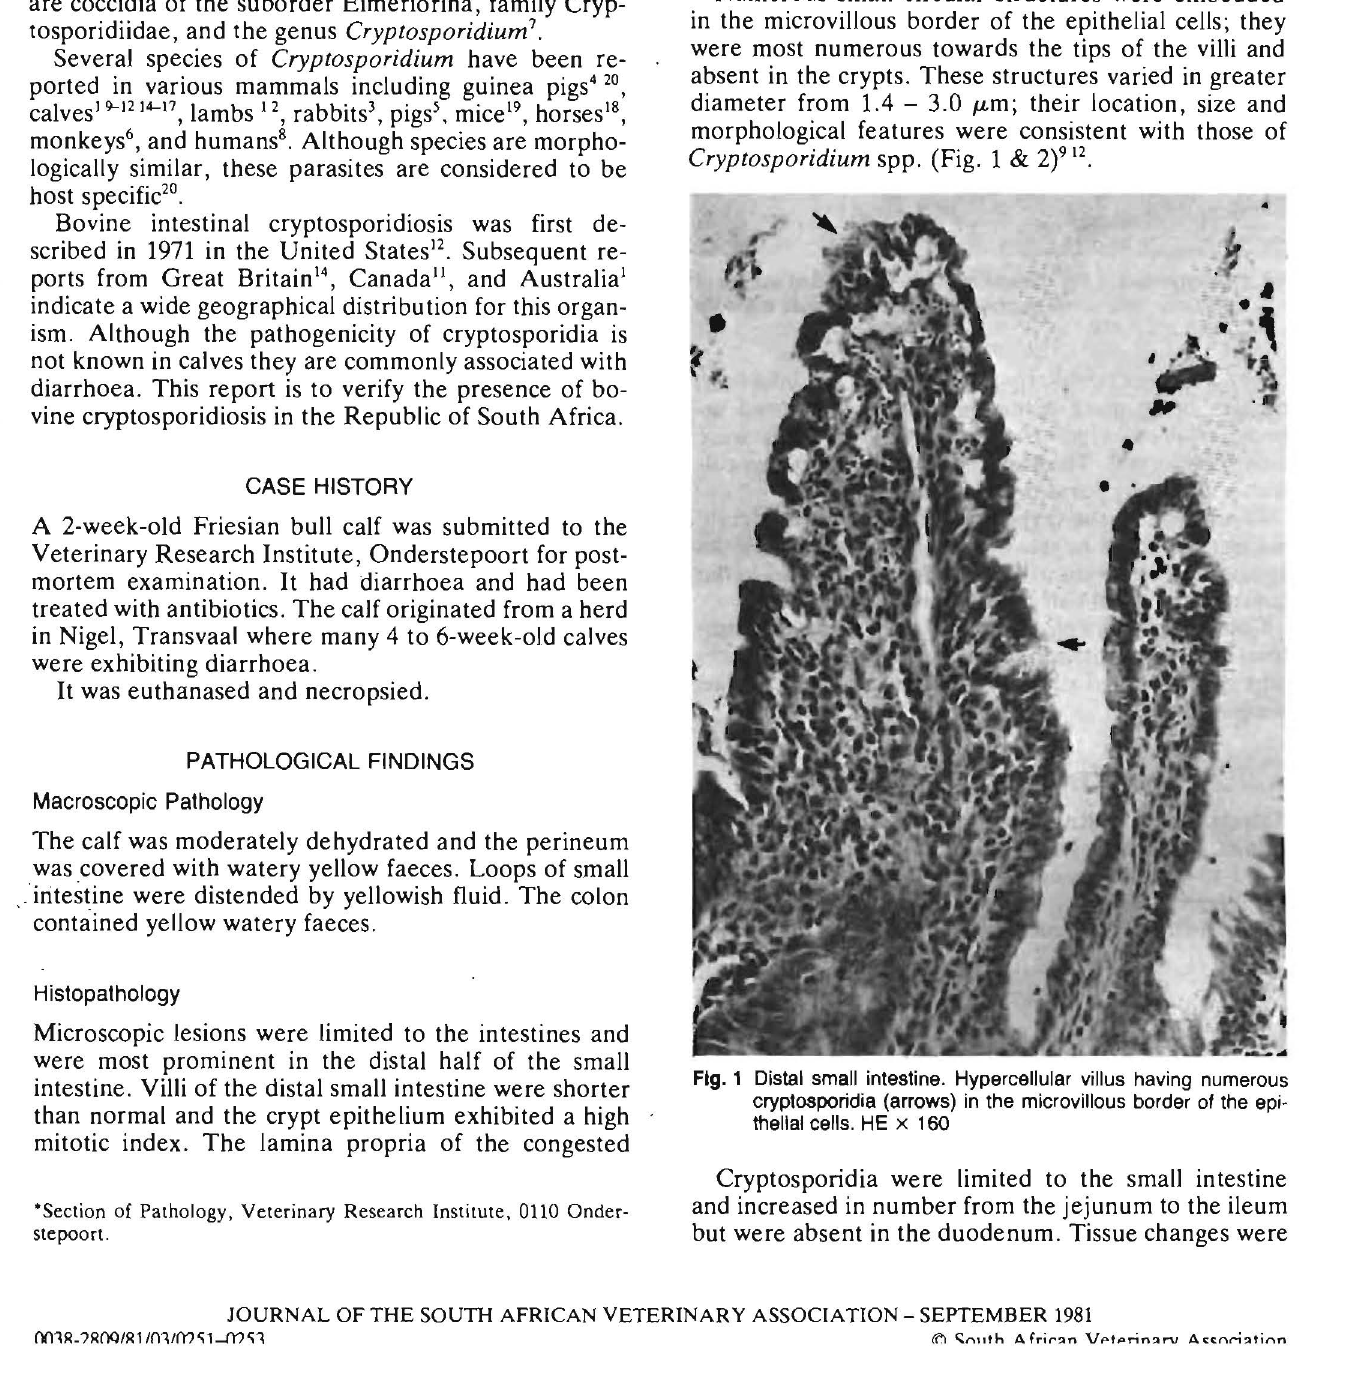
Fig. 1 Distal small intestine. HypercelJular villus having numerous cryptosporidia (arrows) in the microvillous border of the epi thelial cells. HE x